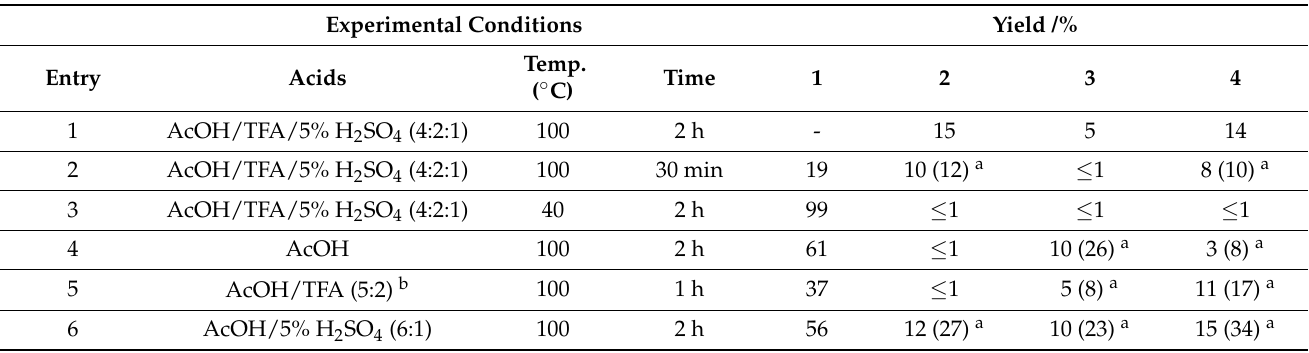
Table 1. The product yield obtained under different reaction conditions (acids used, temperature, and reaction